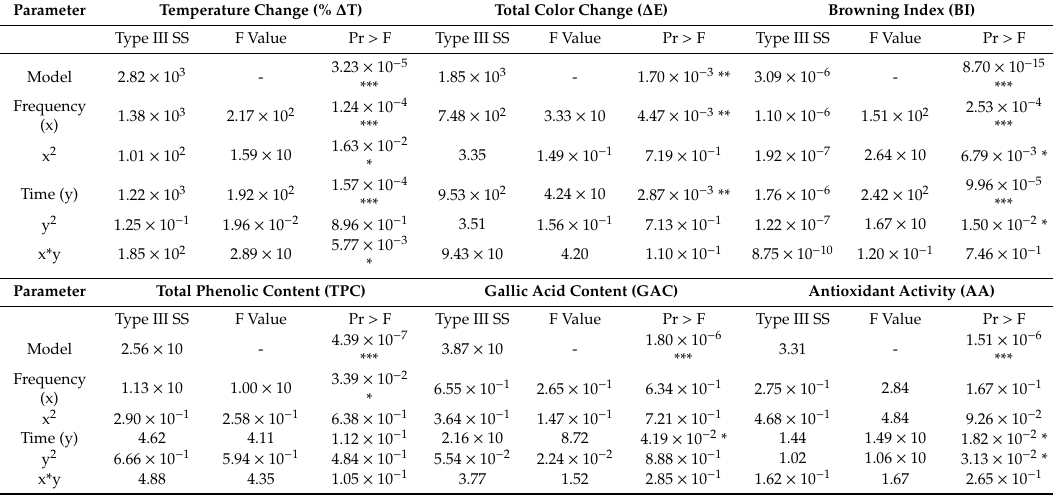
Table 3. Analysis of Variance (ANOVA) table for the influence of PL frequency and time on the physicochemical properties of gallic acid